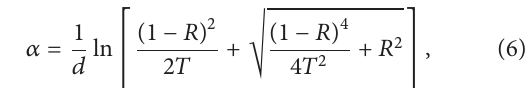
Figure 3: Optical transmittance and reflectance spectra of ITO thin film with a thickness of 199nm.